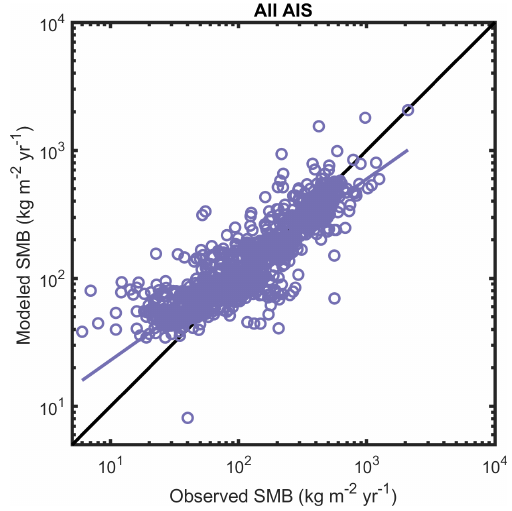
Figure 23. Comparison of N = 1201 observations of SMB with GSFC modeled SMB over the AIS. Note the logarithmic scale.